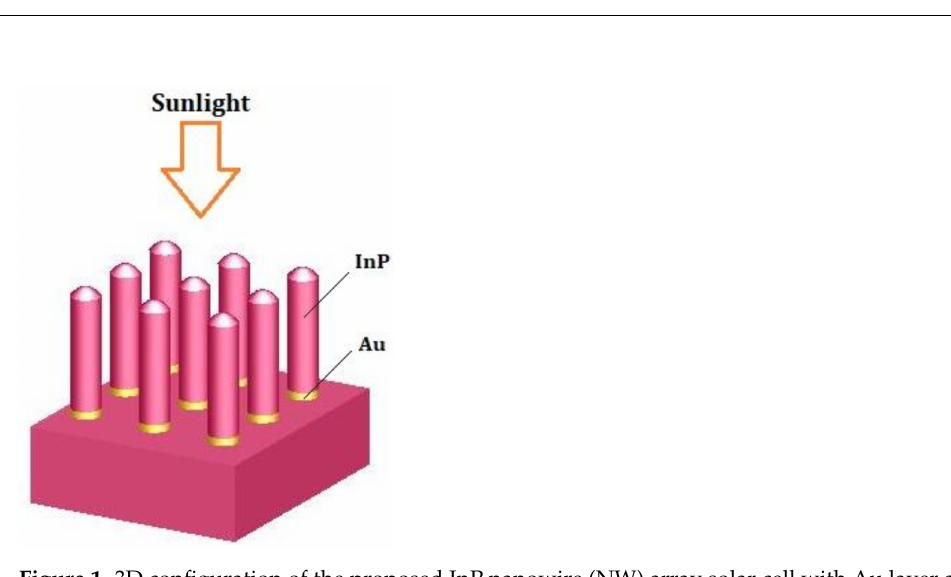
Figure 1. 3D configuration of the proposed InP nanowire (NW) array solar cell with Au layer at the bottom and conical-shaped parabola on the